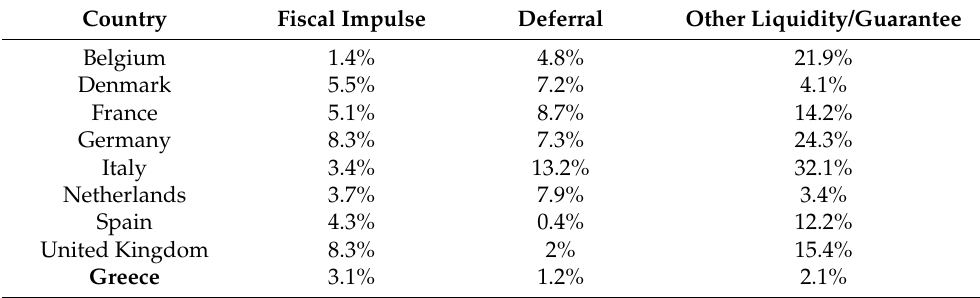
Table 4. Fiscal Measures adopted to confront COVID-19 (% GDP